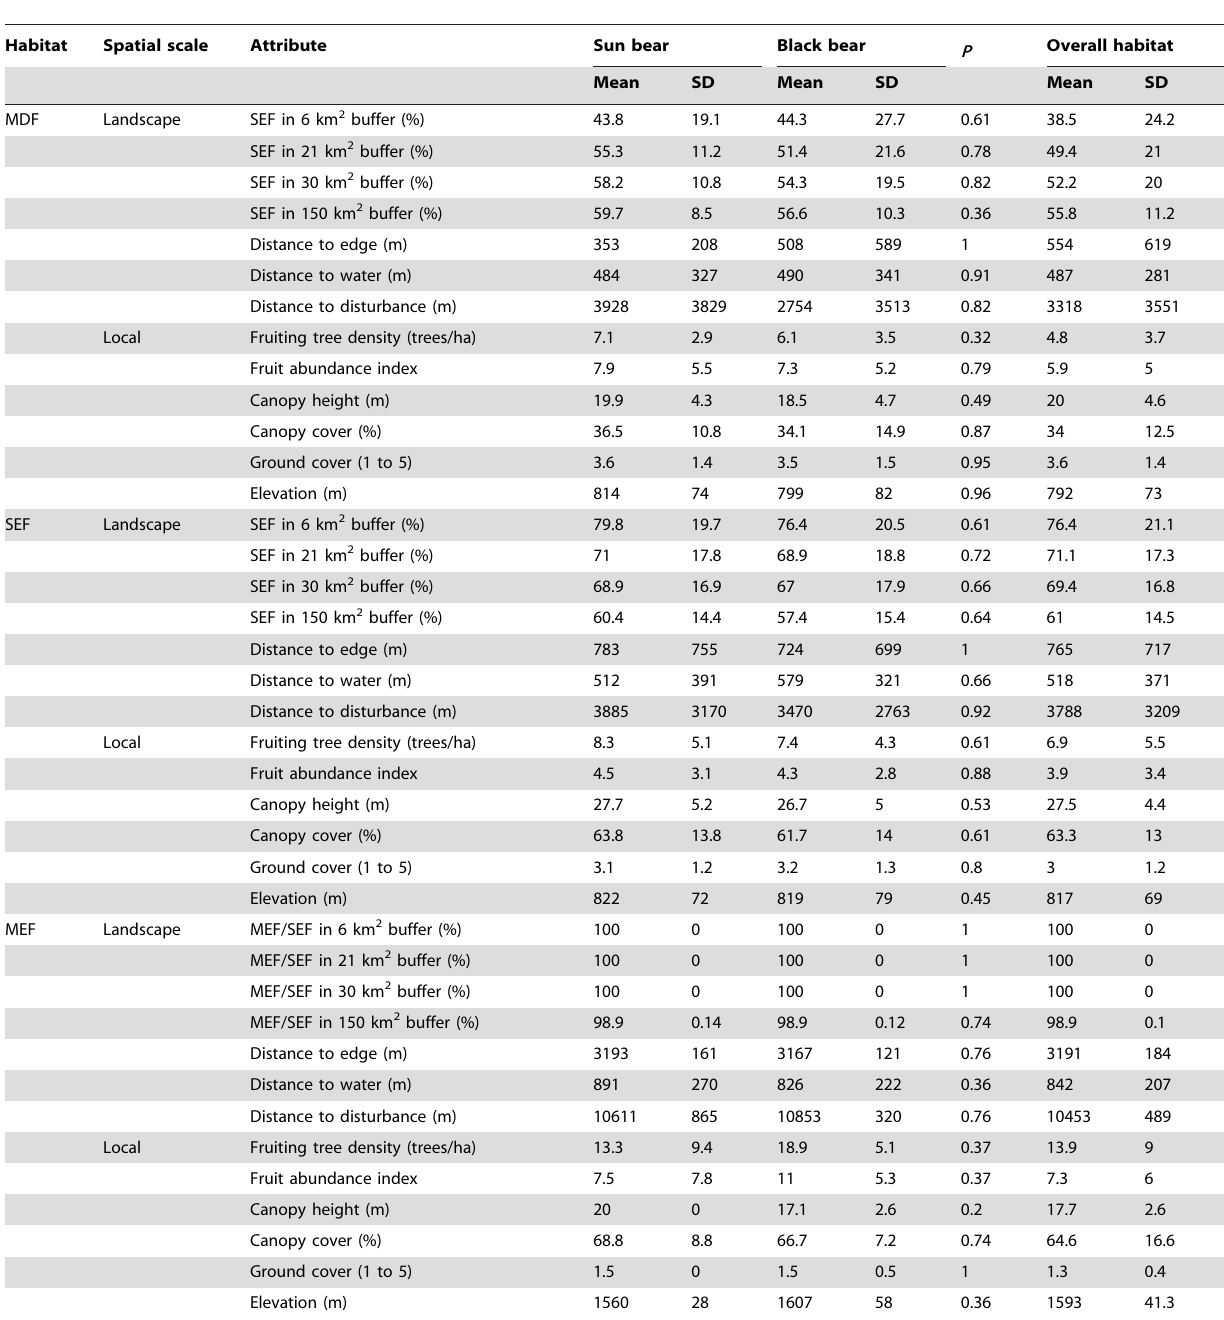
Table 2. Habitat attributes at sites where fresh signs ( , 3 months) of sun bears and black bears were detected in Thung Yai Naresuan Wildlife Sanctuary, Thailand, 2001–2003.